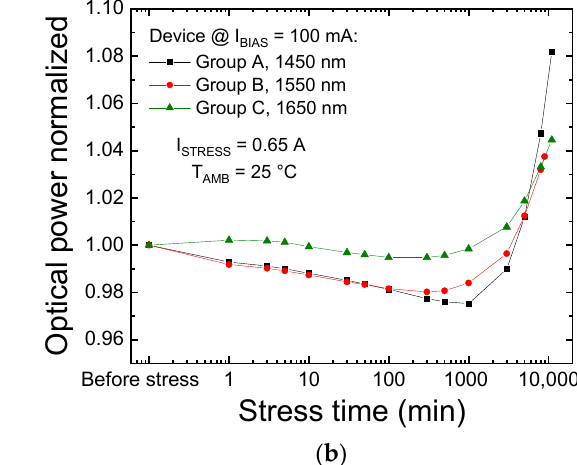
stress procedure. The dashed line represents the reference level, corresponding the optical emission of the unaged device at each measuring temperature.